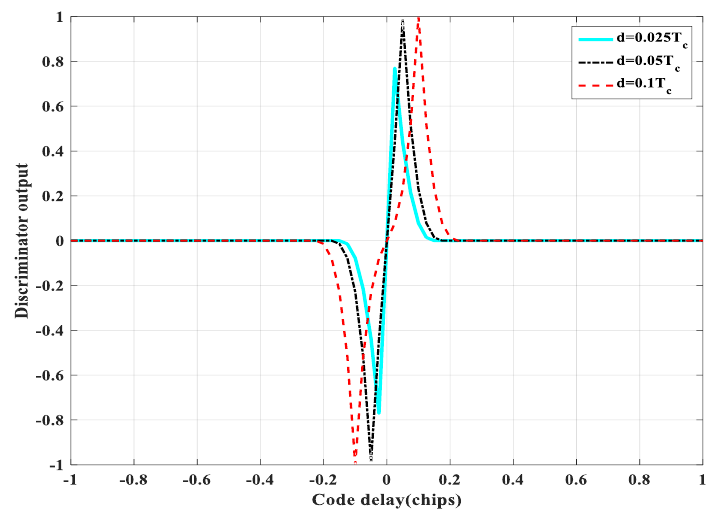
Figure 17. The discriminator curve at different delay spacings of BOC(1, 1).